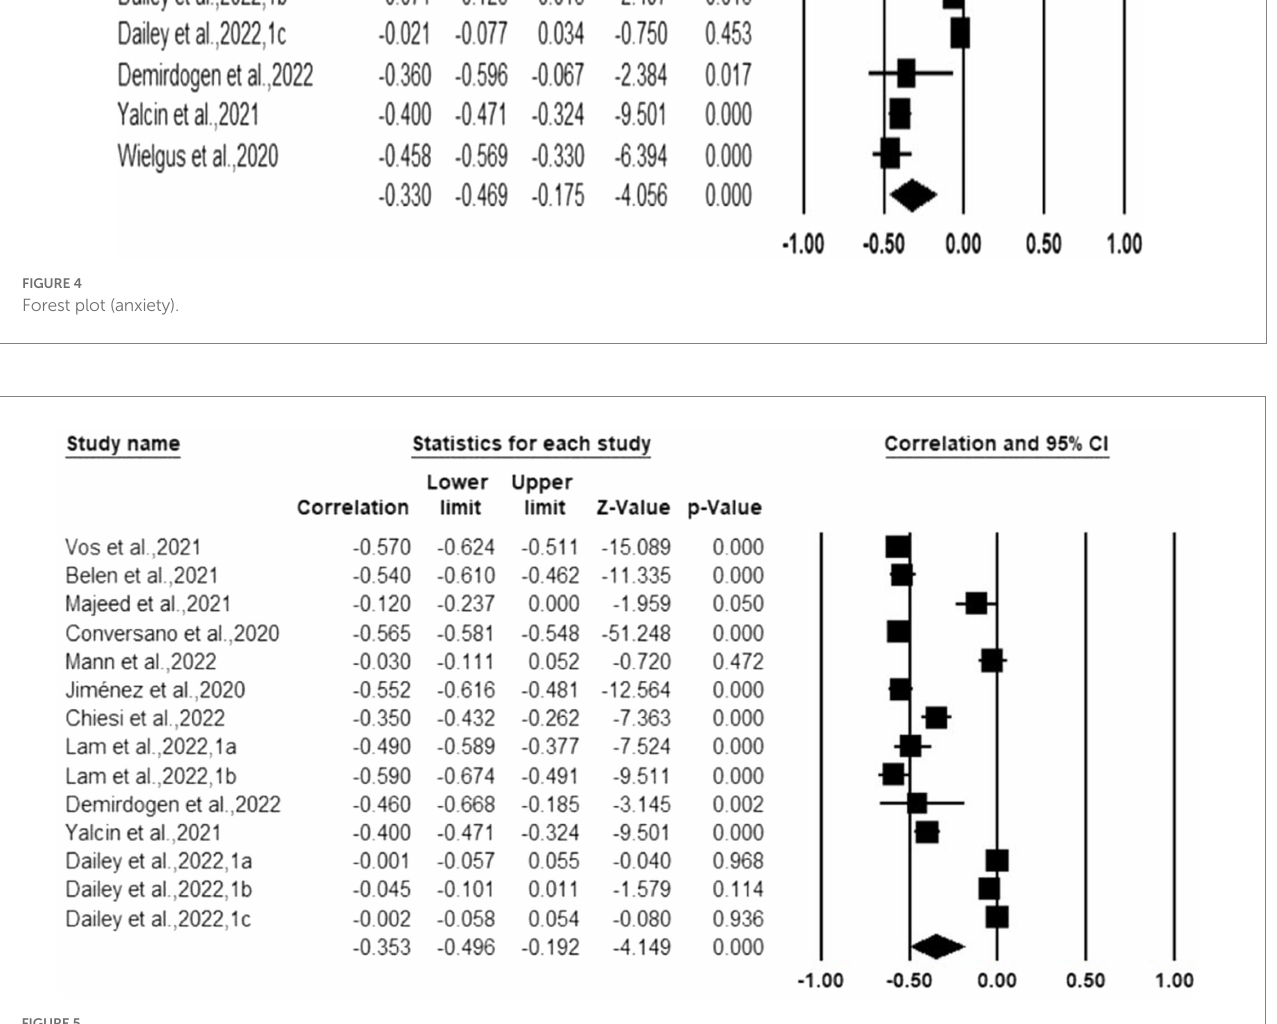
FIGURE 5 Forest plot